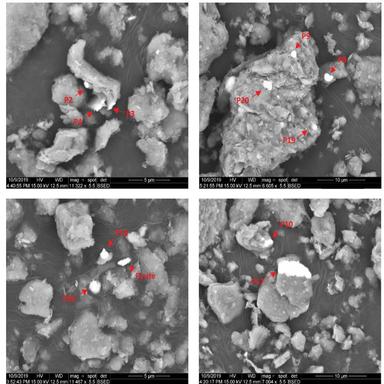
SEM-BSE images of the REE-bearing particles found in SP25-F1 (P1–P18: non-phosphate rare earth minerals; P19–P27: enriched-phosphate rare earth minerals).